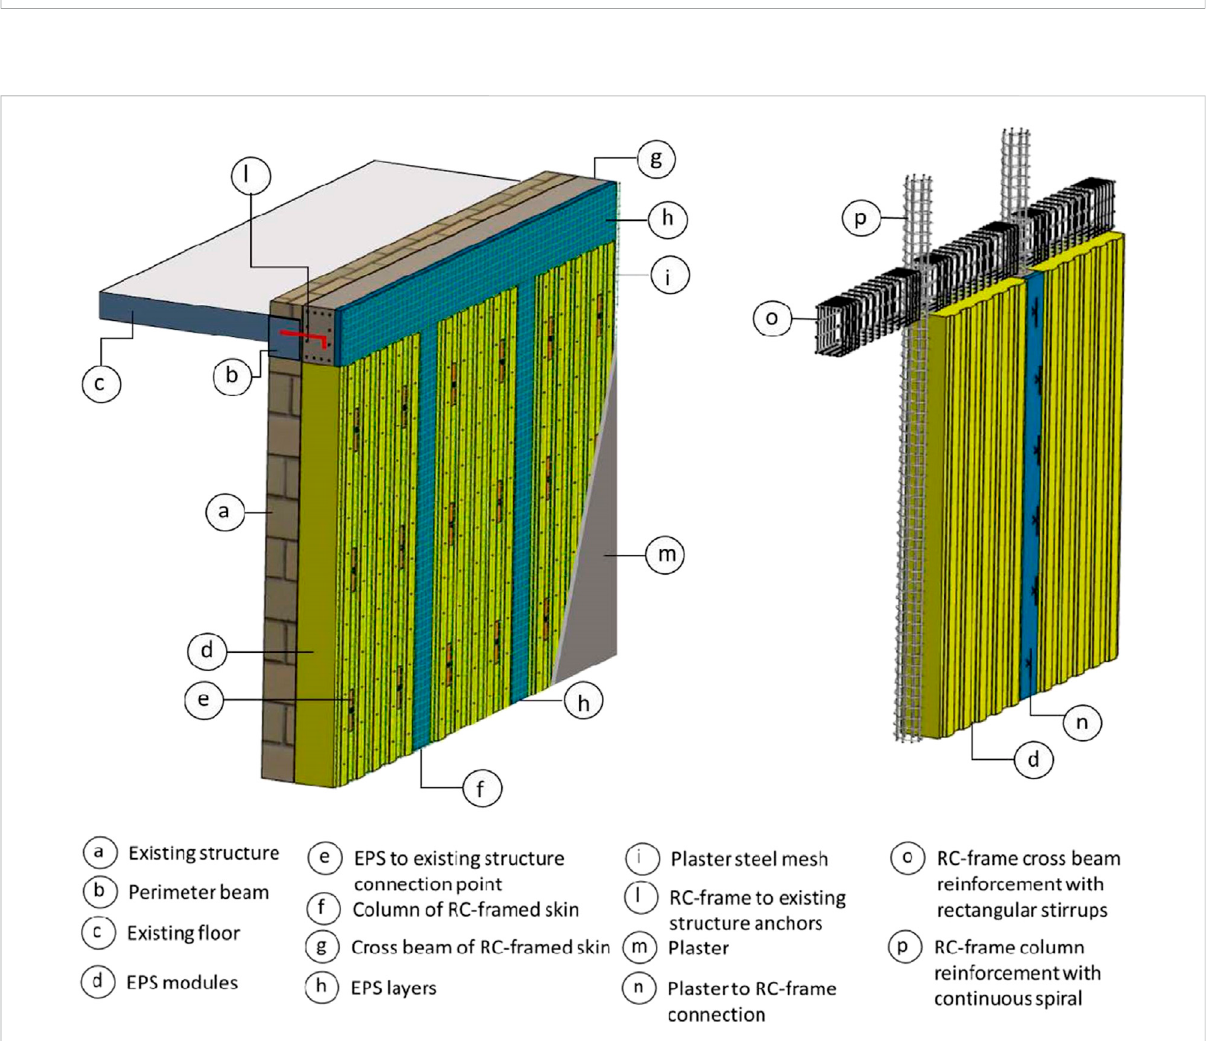
FIGURE 5 RC frame exoskeleton: global view (left); detail of EPS insulation panel and steel reinforcement (right) (Pozza et al., 2021).